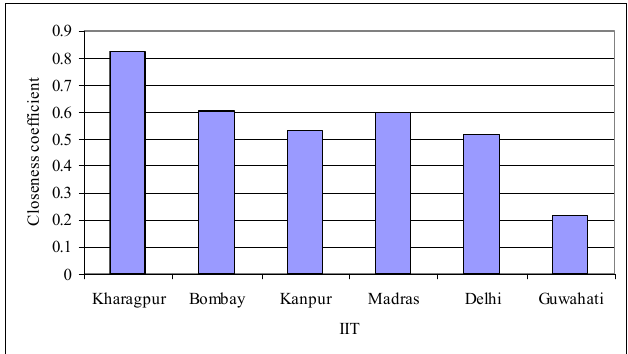
Fig. 1. DEA-TOPSIS method-based ranking of six